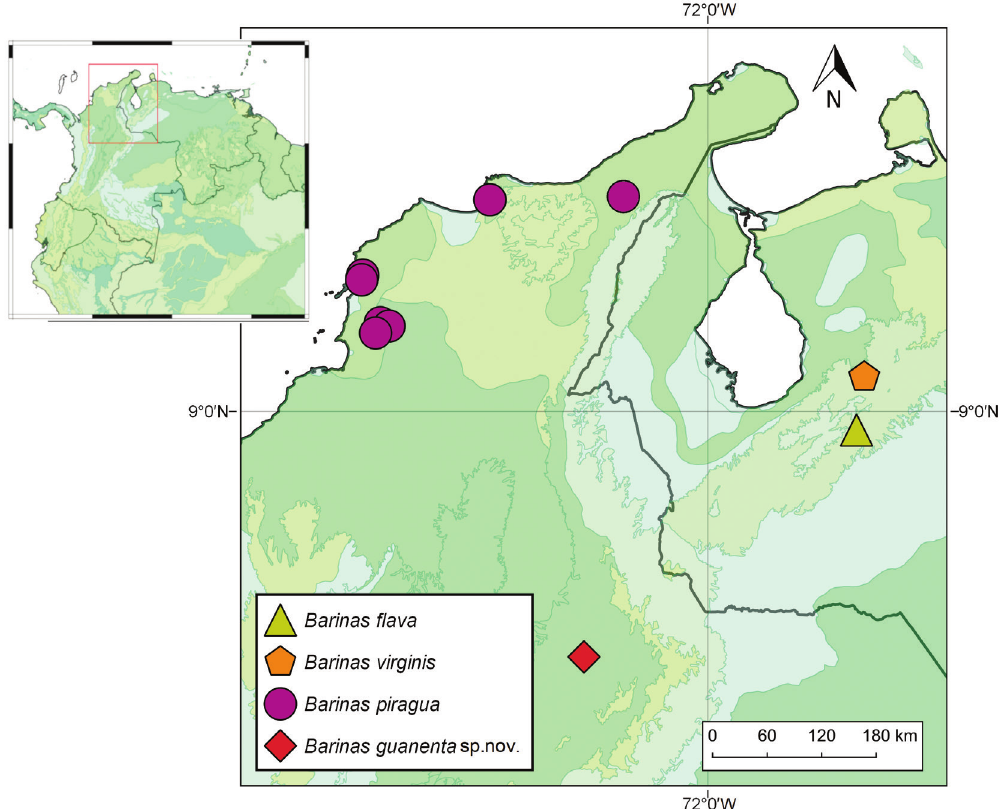
Figure 4. Map showing the distribution of Barinas in Northern South America. Colored shapes refer to WWF Terrestrial Eco-re- gions of the World (Olson et al.